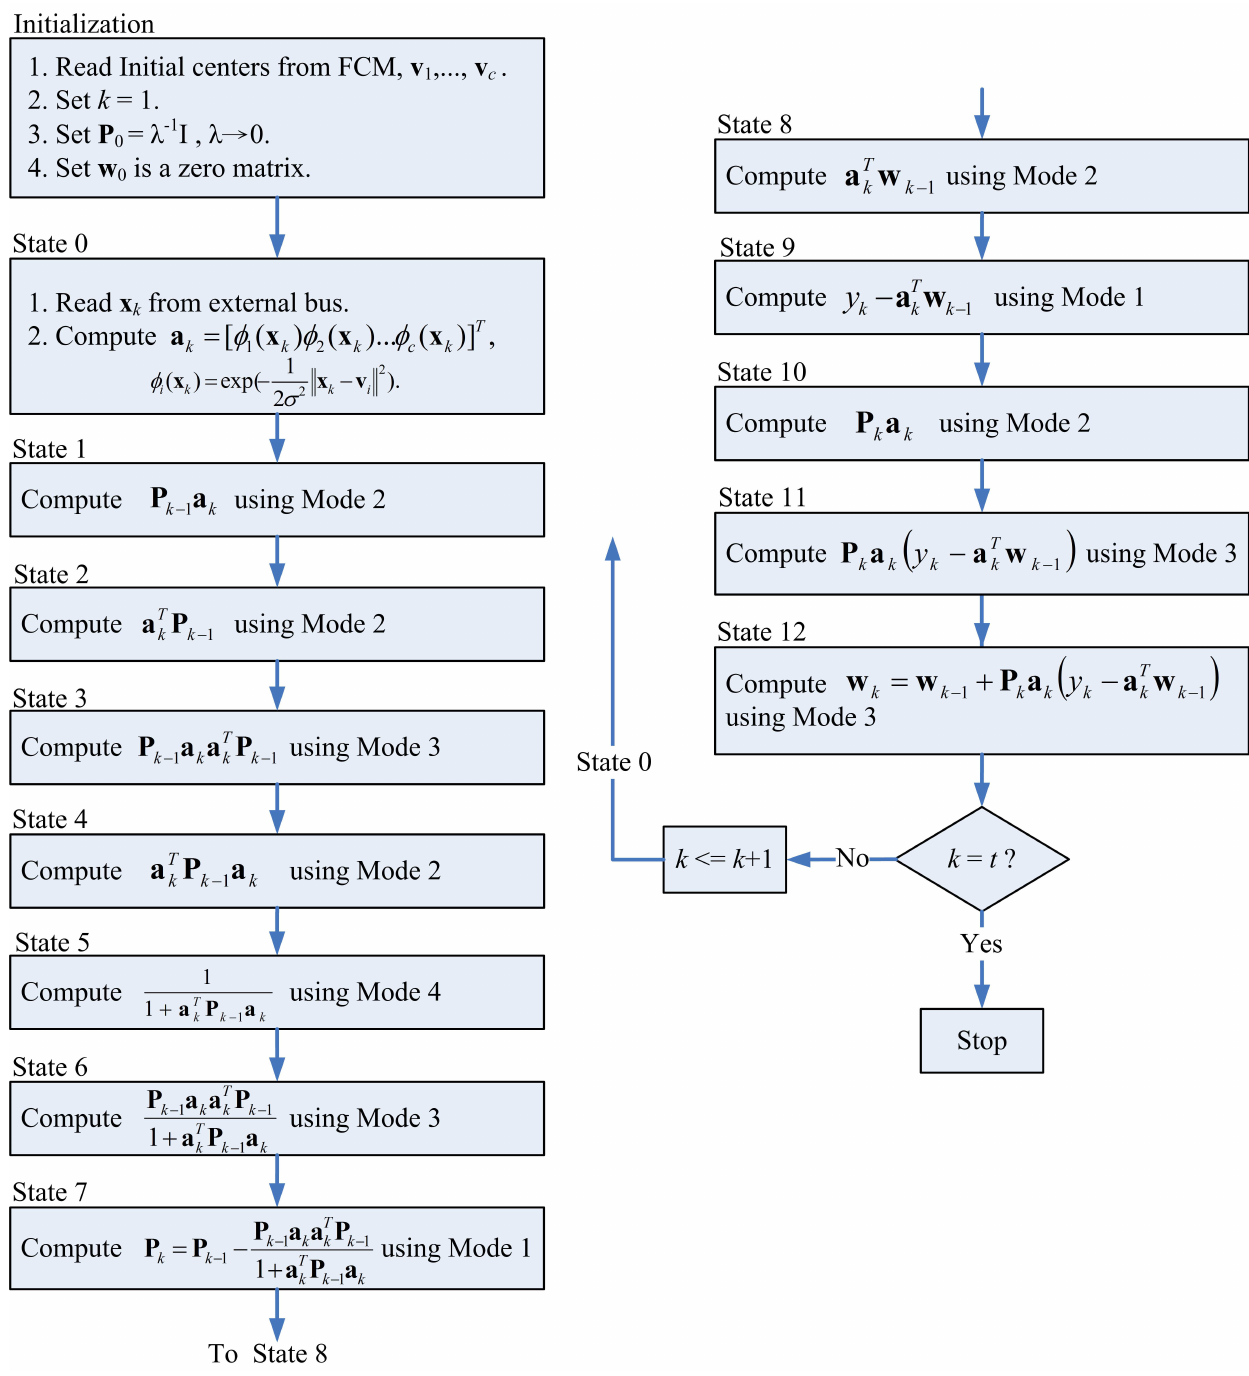
Figure 13. The state diagram of the control